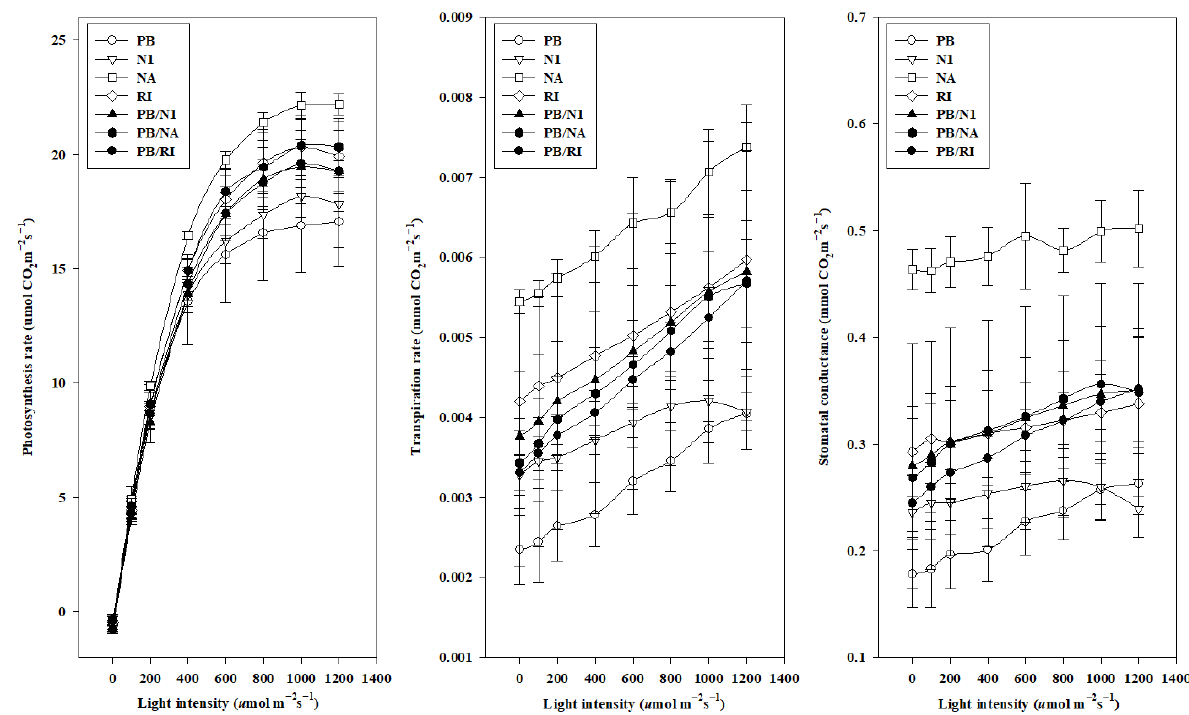
Figure 8. Photosynthetic parameters of one scion, three rootstocks, and three grafted plants under different light intensities. (PB): scion cut rose of Rosa hybrida cv. Pink Beauty; (N1): rootstock of Rosa multiflora cv. Hort No 1; (NA): rootstock of Rosa canina cv. Natal brier; (RI): rootstock of Rosa indica cv. Major; (PB/N1): PB grafted onto N1; (PB/NA): PB grafted onto NA; (PB/RI): PB grafted onto RI. Vertical bars are standard deviations ( n = 3).